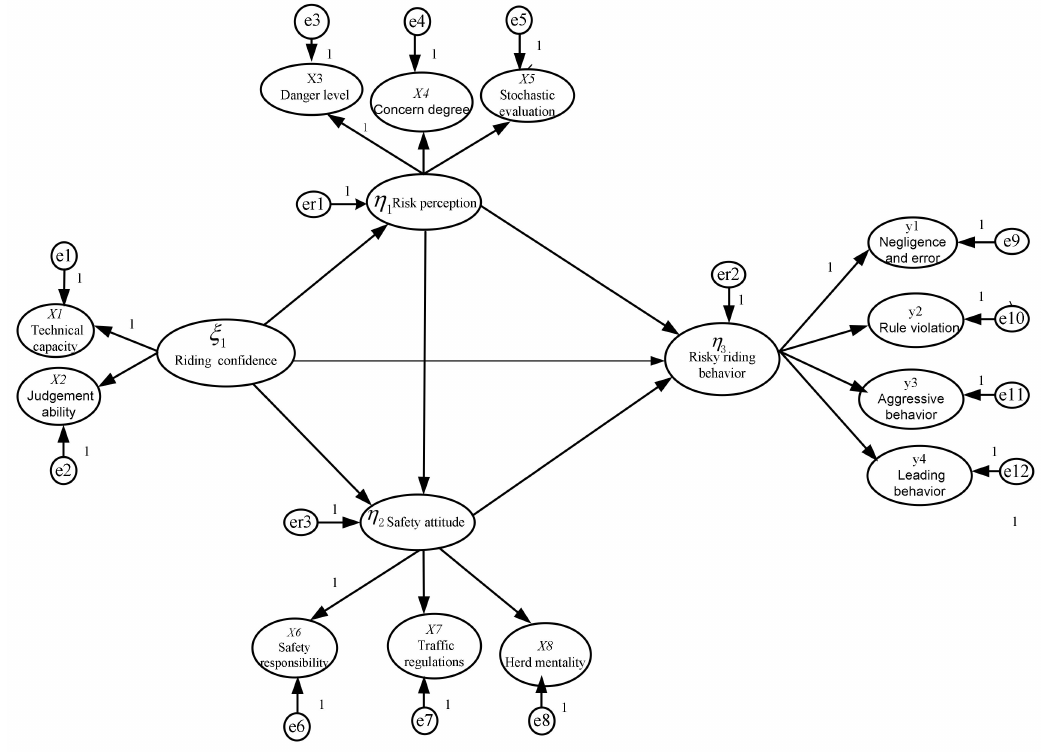
Figure 1. Theoretical structure model of risky riding behavior.